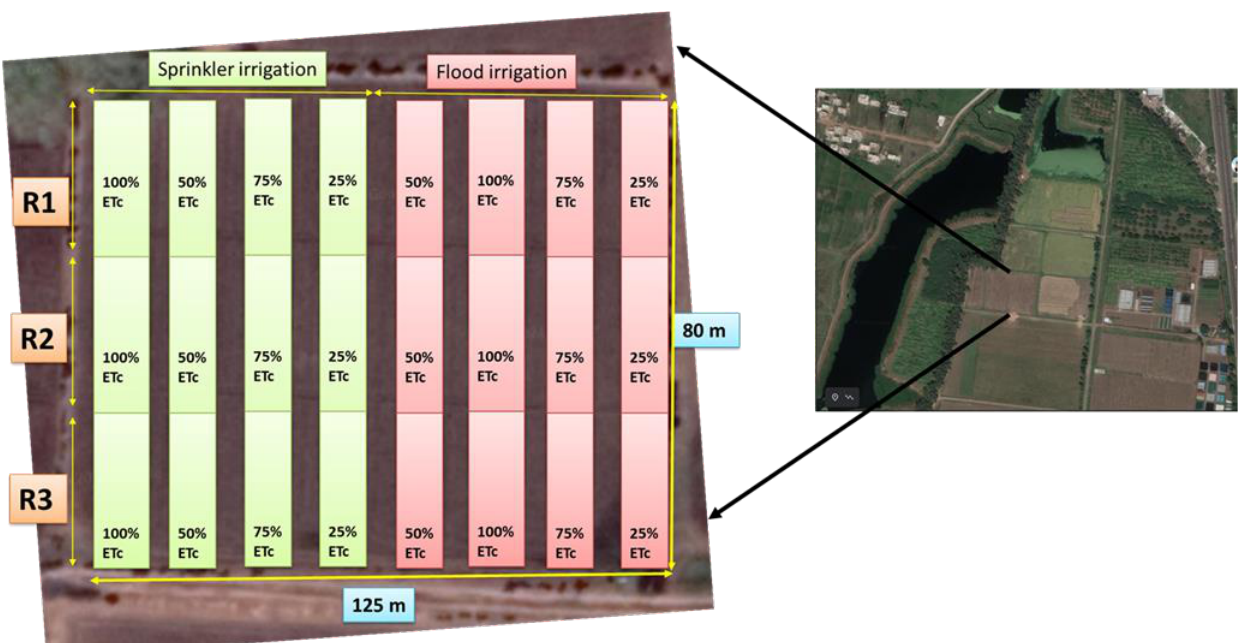
Figure 1. Experimental layout of the winter wheat crop irrigated at different rates using sprinkler and flood irrigation systems [32]. R — Replicates. Layout is prepared over google map.